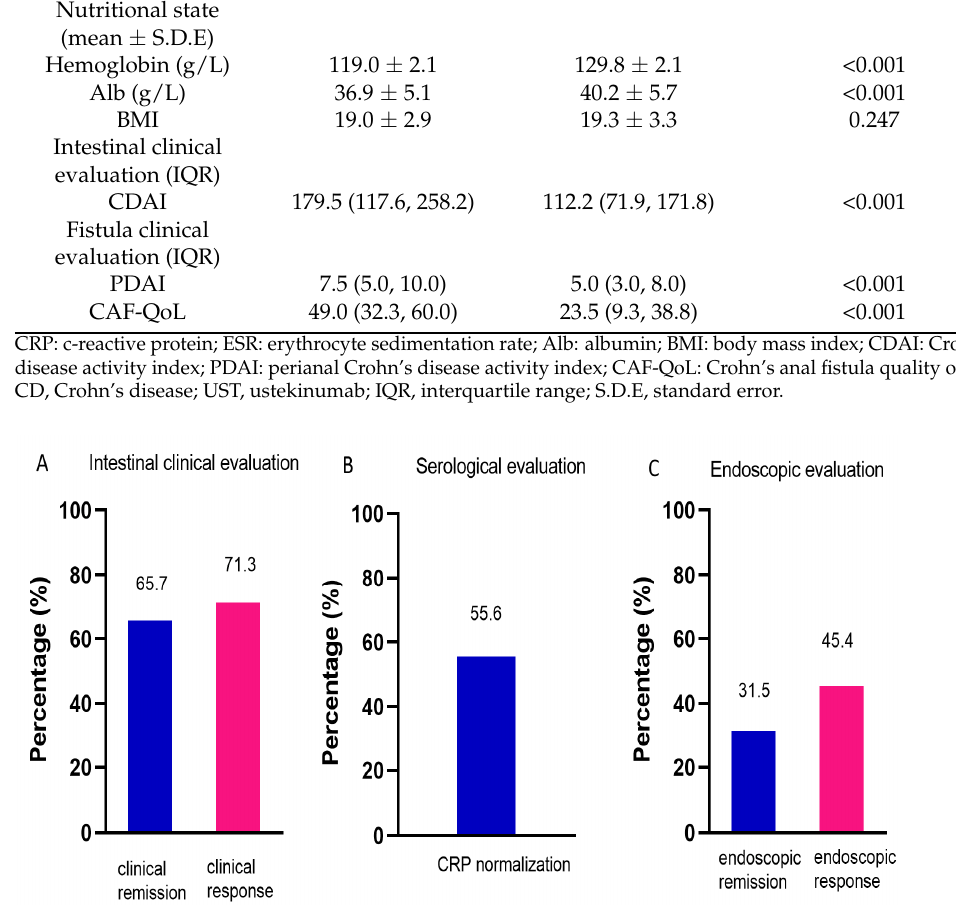
Figure 2. Efficacy of UST on CD. ( A ) Intestinal clinical evaluation using CDAI at week 16/20, n = 108. ( B ) Serological evaluation determined by CRP levels, n = 108. ( C ) Endoscopic evaluation using Rutgeerts score or SES-CD, n = 99. UST: ustekinumab; CDAI: Crohn’s disease activity index; CRP: C-reactive protein; SES-CD: simple endoscopic score for Crohn’s disease.